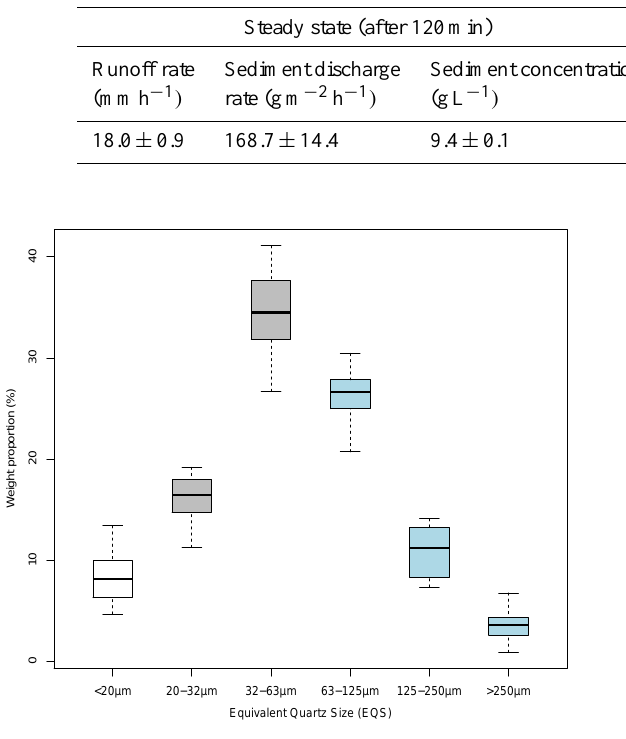
Figure 2. The weight distribution of different Equivalent Quartz Size (EQS) classes of the sediment. Colors of the boxes correspond to the likely fate of each fraction after erosion. See Sect. 4.1 and Fig. 6 for definitions and explanation of the three manners of likely fate. Bars in the boxes represent median values. Whiskers indicate the lowest datum within 1.5 interquartile range of the lower quartile, and the highest datum within 1.5 interquartile range of the upper quartile ( n = 18).